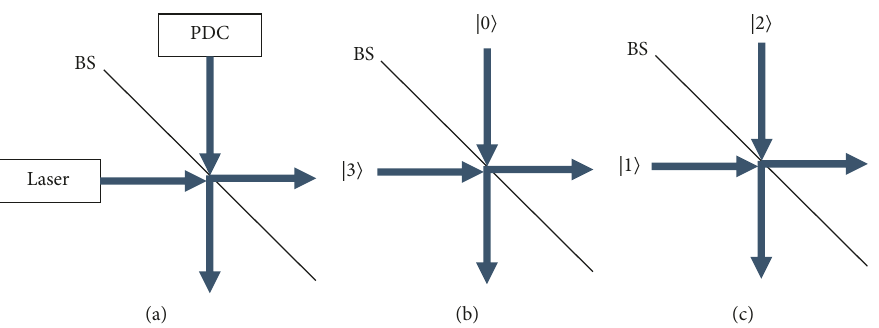
Figure 1: (a) The setup for mixing laser and PDC lights at a BS. There are 2 distinct ways to mix laser and PDC photons leading to 3-NOON state: (b) No photons from PDC and 3 photons from laser, and (c) 2 photons from PDC and 1 photon from laser.